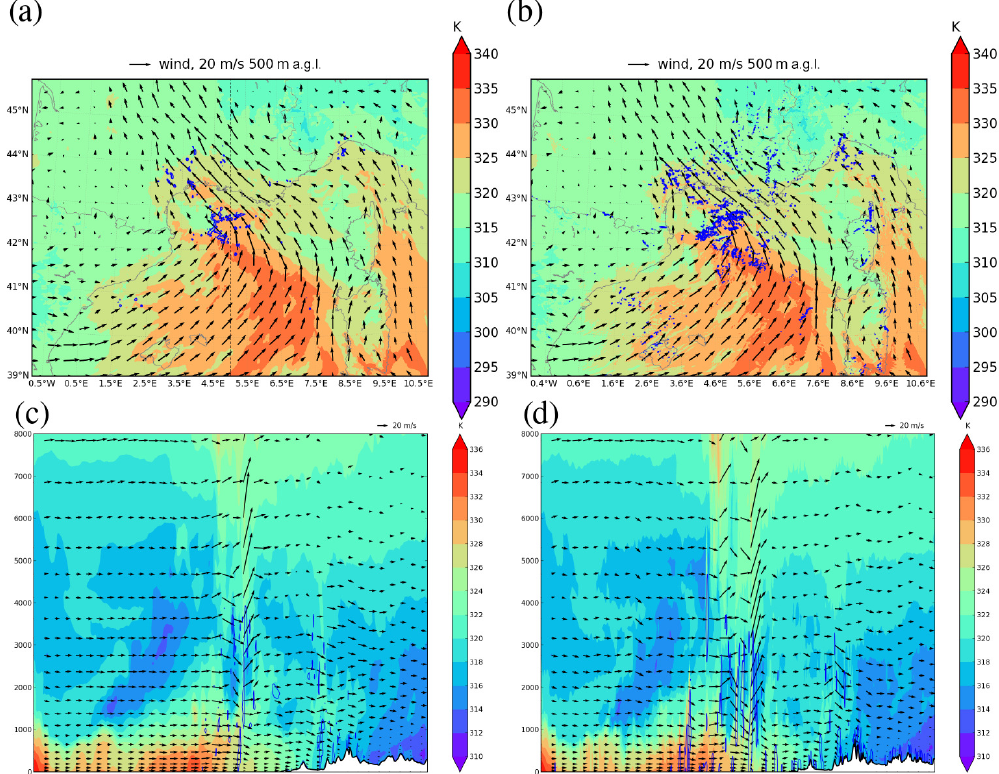
Figure 7. IOP16: 09:30UTC, 26 October 2012. Horizontal cross sections at 500ma.g.l. and vertical cross sections along a south–north line (shown in a ) of equivalent potential temperature (K, in color scale), as well as wind vectors (m s − 1 , black arrows) for 2km (a, c) and 500m (b, d) resolution runs. The blue lines represent the humidity convergence ( − 0.1kgs − 1 m − 3 for vertical cross sections and − 0.02kgs − 1 m − 2 integrated over the layer between the ground and 3000m for horizontal cross